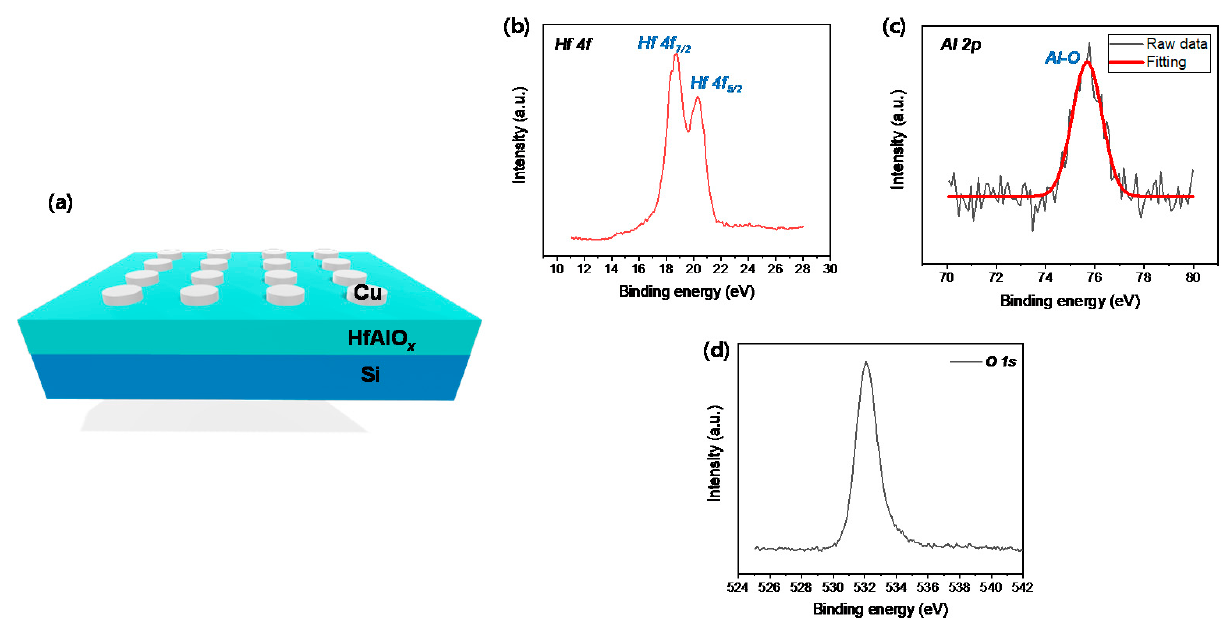
Figure 1. ( a ) Schematic of Cu/HfAlO x /Si device. ( b ) Hf 4f, ( c ) Al 2p and ( d ) O 1s spectra of HfAlO x film.